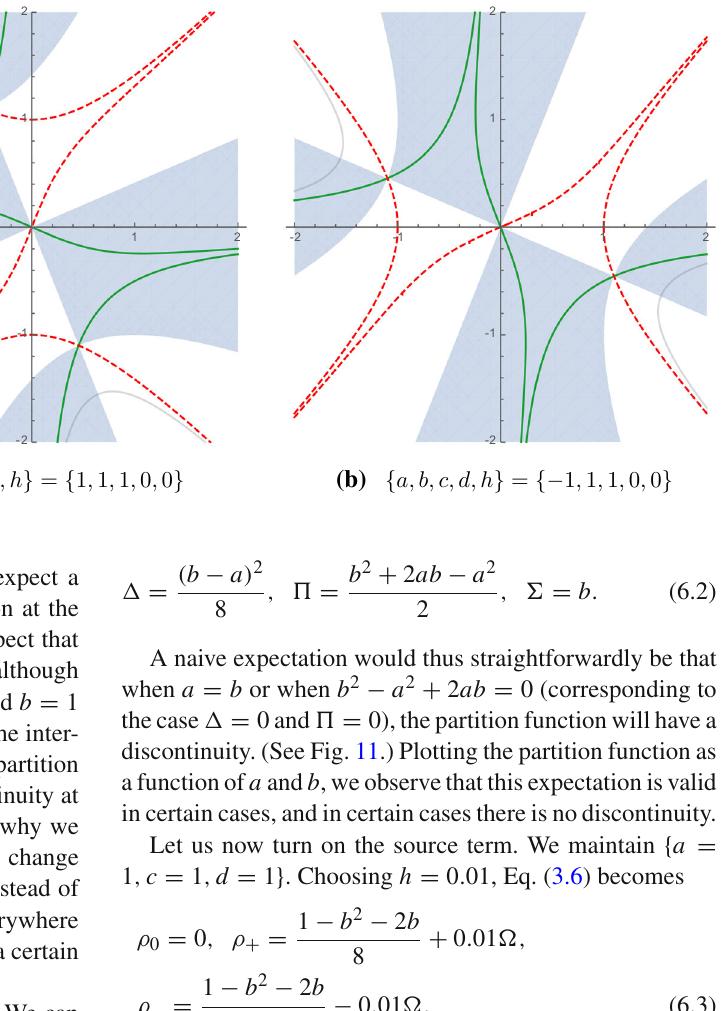
value. Clearly, there is a discontinuity/kink at a = a c = 0. This discon- tinuity is due to the change in the intersection number of φ ± from zero, for a > 0, and one for each critical point, when a < 0